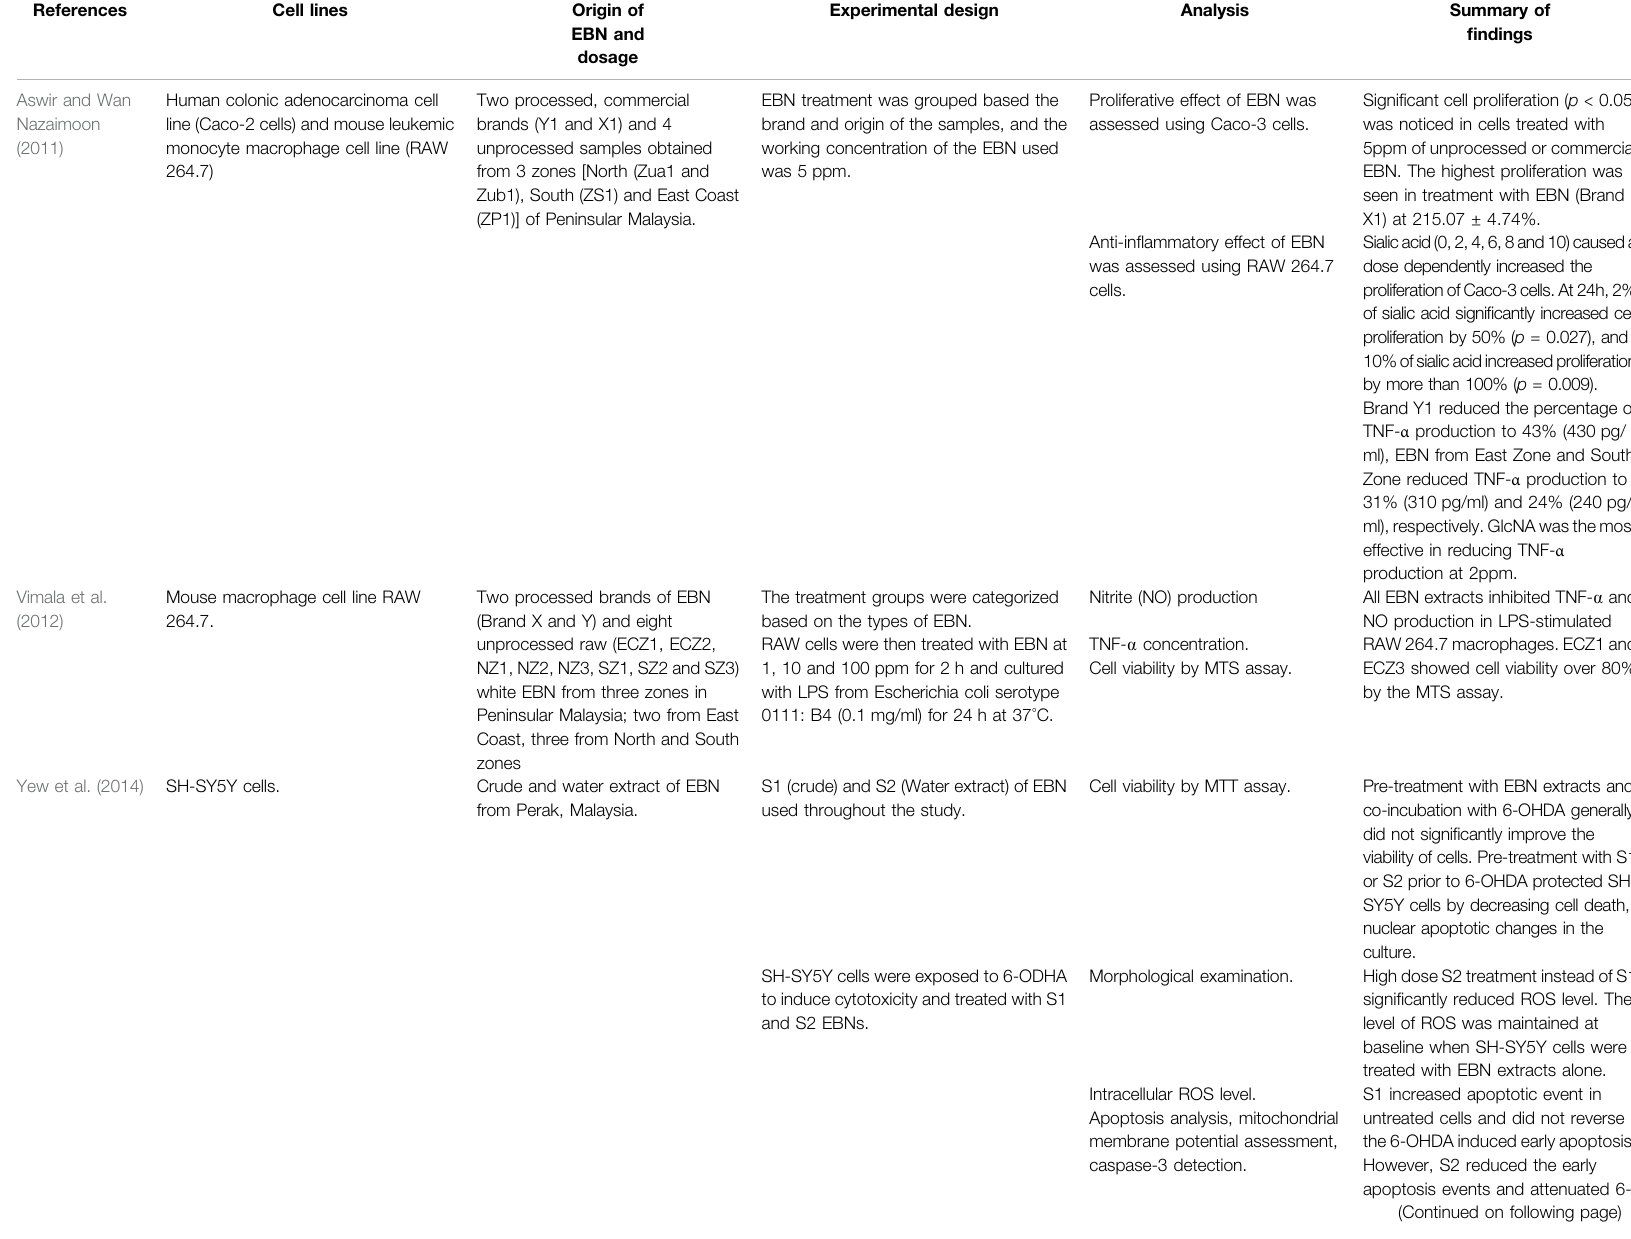
TABLE 5 | Anti-in fl ammatory effects of